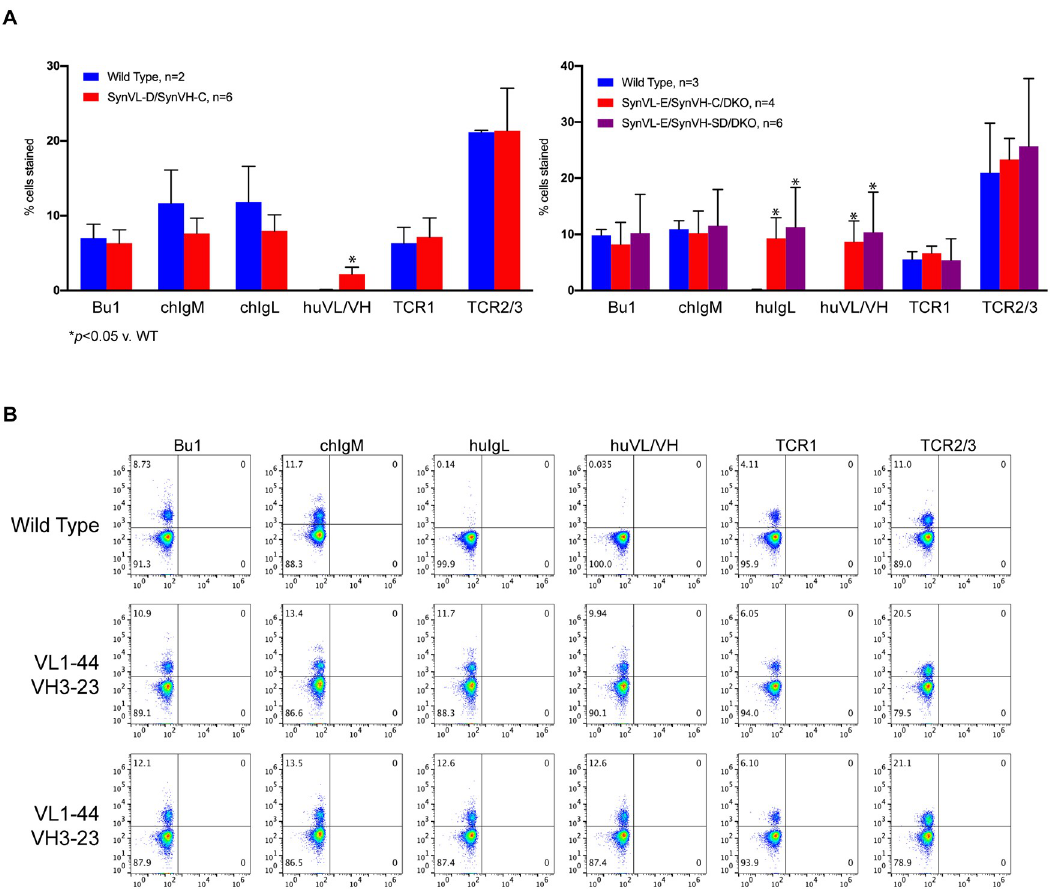
Fig 1. V λ -expressing OmniChickens demonstrate normal B cell populations in the periphery. (A) Circulating lymphocytes were isolated from SynVL-D (left panel) and SynVL-E OmniChickens (right panel) and stained for Bu1, a chicken B cell marker, chIgM ( μ -specific), chIgL (chCL specific), huIgL (huCL specific) and two different T cell markers. Additionally, a polyclonal antibody raised against the inserted human transgenes was used (huVL/VH). Populations were compared to age-matched wild-type chickens, and no difference in B and T cell populations were observed (Student’s T-test, p > 0.05). Error bars represent the standard deviation from the mean. (B) Representative plots from SynVL-E OmniChickens show a distinct population of cells expressing surface Ig, and two human specific antibodies demonstrate expression of the human V at the cell surface. Data are representative of several independent experiments.